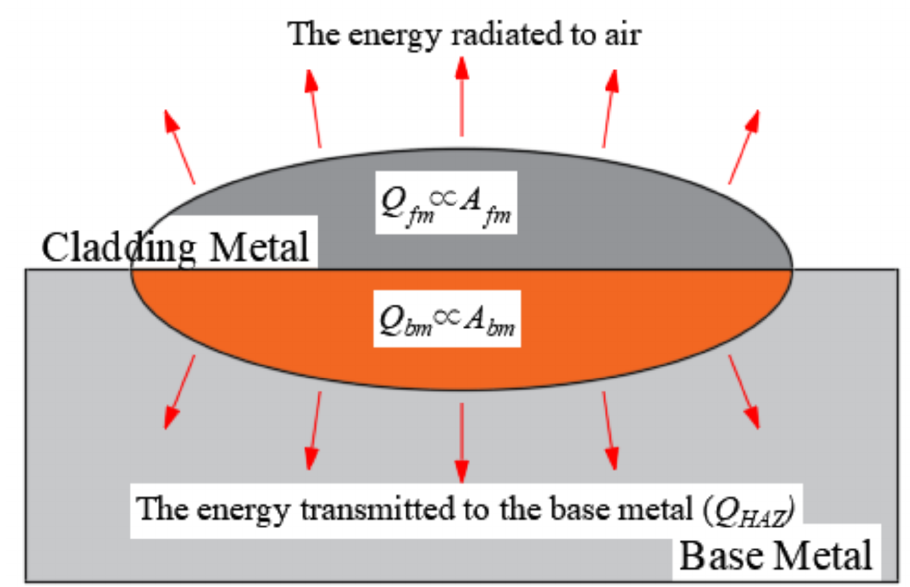
Figure 2. Schematic diagram of calculating the dilution ratio by heat